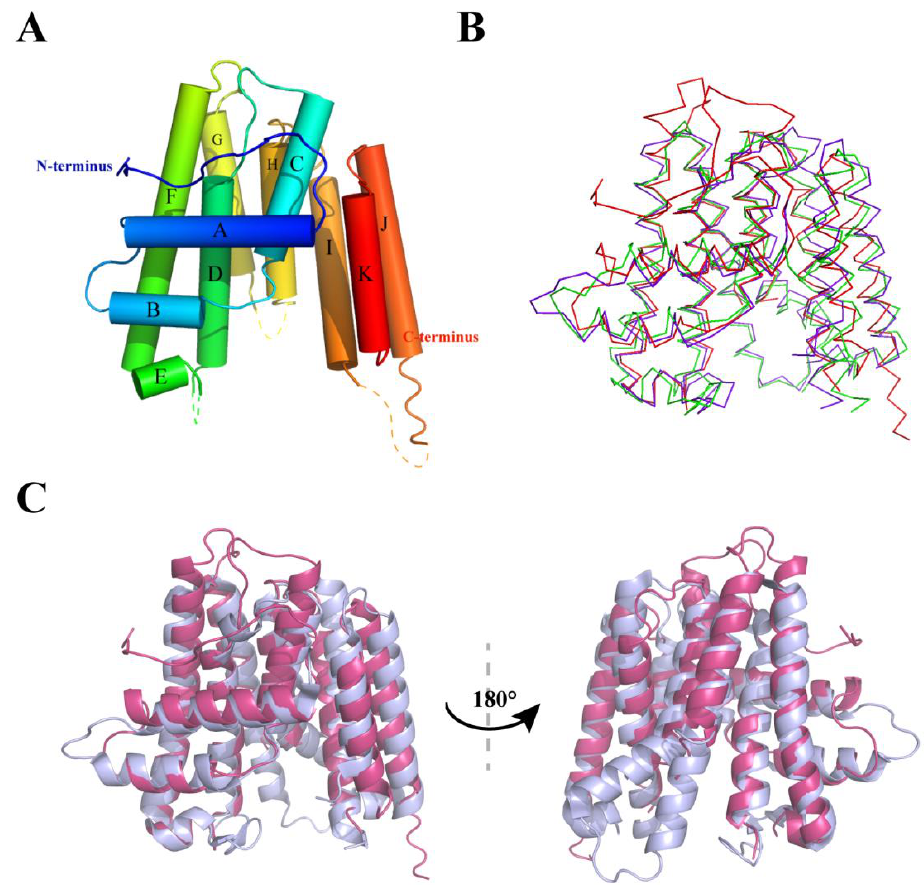
Figure 6. The overall structure of the B318L protein and structural comparison to its homologs. ( A ) Cartoon view showing the overall fold of the ASFV B318L structure. The structural cartoon is colored in rainbow, from blue (N-terminus) to red (C-terminus). ( B ) Superposition of B318L, Clostridium perfringens GGPPS, and Mentha piperita GGPPS structures. Structures are shown as ribbons and are colored red (B318L), blue ( Clostridium perfringens GGPPS), and green ( Mentha piperita GGPPS). ( C ) Superposition of the structures of the ASFV B318L and Clostridium perfringens GGPPS in a front view and back view. The structure of B318L and Clostridium perfringens GGPPS are shown as a cartoon in red and blue, respectively.